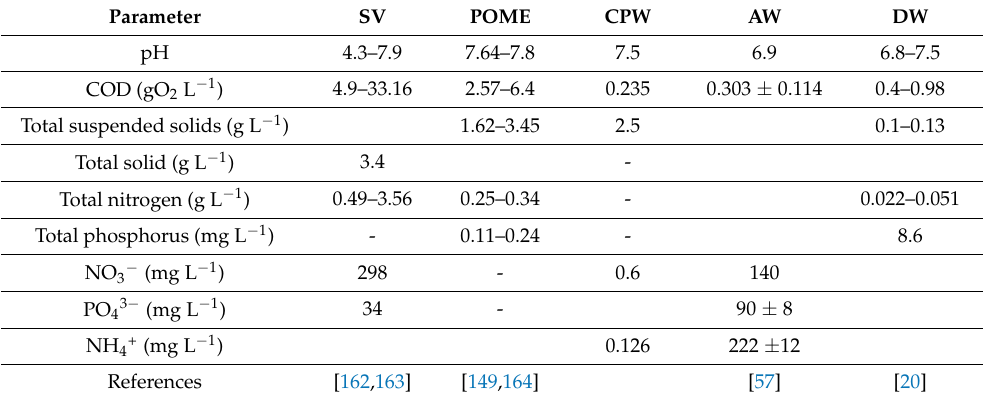
Table 3. Physicochemical characteristics of secondary effluents from the anaerobic digestion of wastewaters that can be considered for microalgae